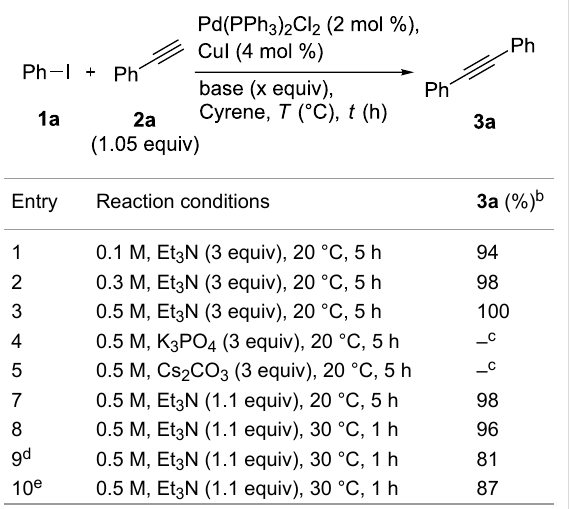
Table 1: Reaction optimisation and comparison with existing solvents.